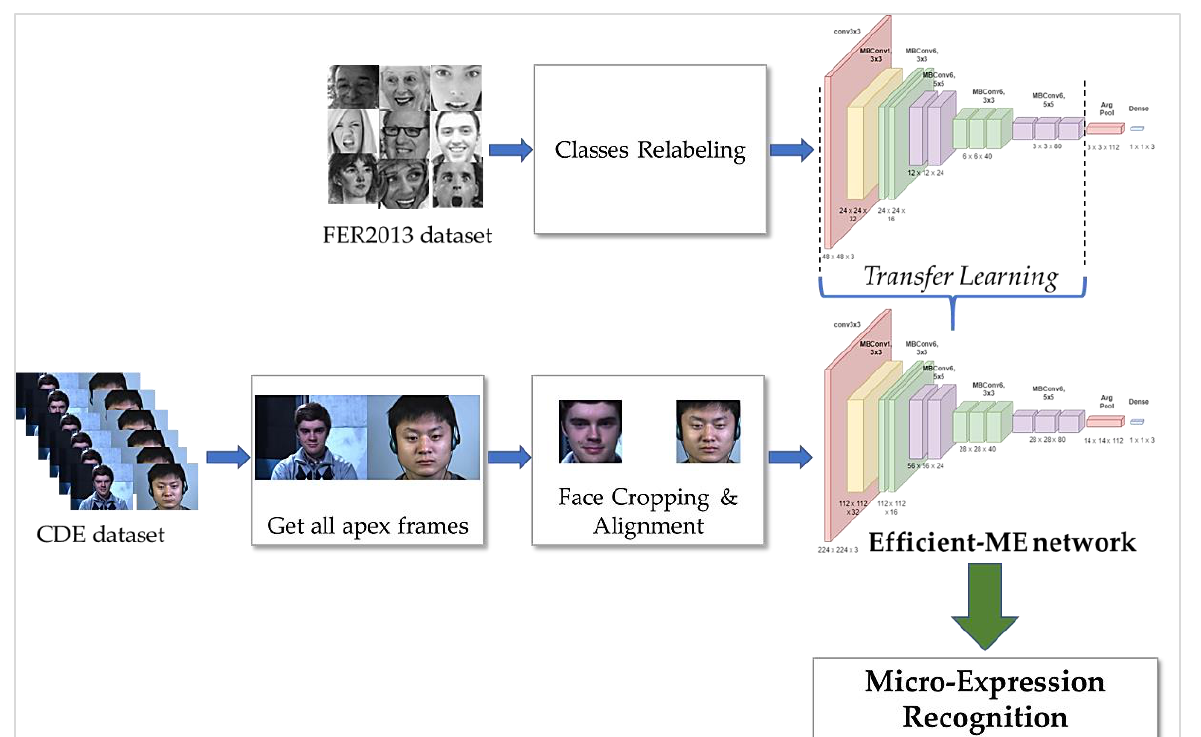
Figure 1. Proposed approach for Micro-Expression Recognition.